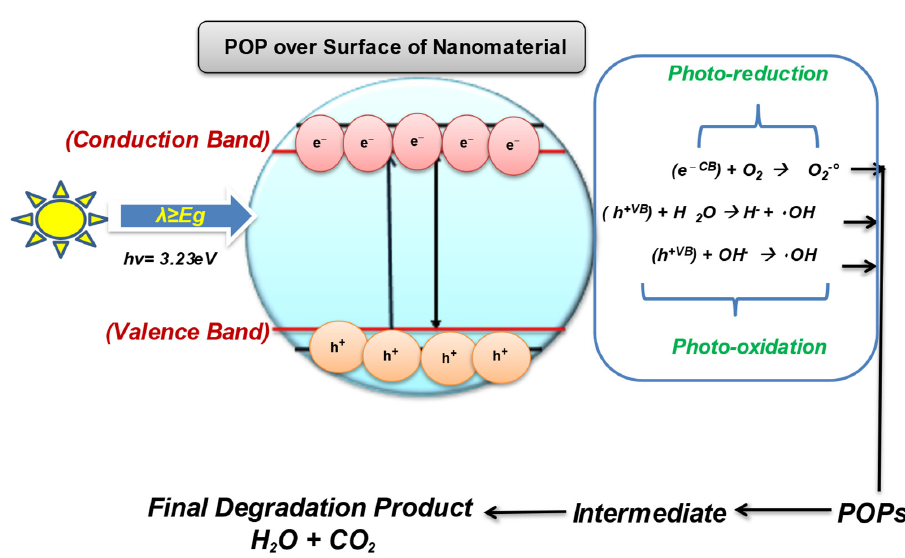
Figure 4. Photocatalysis over the surface of the nanomaterial.